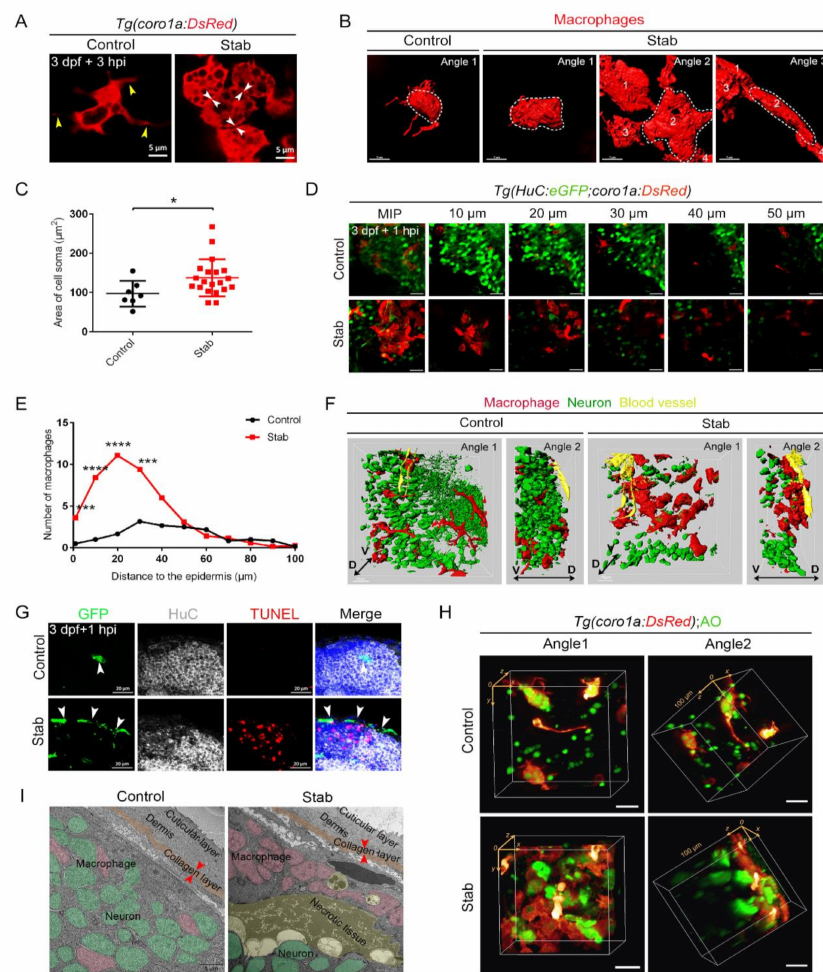
Figure 3. Aggregated macrophages formed a honeycomb network structure covering the wound surface. ( A ) Changes in macrophages morphology after injury. The yellow arrowheads indicate the branches. The white arrowheads indicate tight connections between cells. Scale bar, 5 µ m. ( B ) Three-dimensional reconstruction of the morphology of macrophages after injury. Angle 1 shows the morphology of individual cells and Angles 2 and 3 indicate tight connections between cells. Scale bar, 7 µ m. ( C ) Statistic analysis of the area of cell soma surface at 3 hpi. Control, 97.08 ± 12.37 µ m 2 n = 7; Stab, 137.50 ± 10.61 µ m 2 n = 20. ( D ) Distribution of macrophages and neurons on different layers of the Z axis at 1 hpi. The number on each panel represents the distances to the surface. Scale bar, 20 µ m. ( E ) Statistics analysis of coro1a + cells number at different layers with distinct distances from the epidermis at 1 hpi. ( F ) Three-dimensional images of the distribution of macrophages (red) and neuron (green) in Tg(coro1a:DsRed;HuC:eGFP) at 1 hpi. Yellow marks the blood vessels. D, dorsal; V, ventral. Scale bar, 15 µ m. ( G ) The immunofluorescent images of GFP, HuC and TUNEL on the frozen sections of Tg(coro1a:eGFP) brains at 1 hpi. The white arrowheads present the distribution of GFP + cells. Scale bar, 20 µ m. ( H ) The location of macrophages and AO + signals in 3D view. Scale bar, 20 µ m. ( I ) Transmission electron microscope image. Macrophages are in pink, neurons are in green, apoptotic or necrotic tissue is in yellow and the collagen layer beneath the skin is in orange. The red arrowheads indicate the width of the collagen layer. Scale bar, 5 µ m. (Data are shown as mean ± SEM. *, p < 0.05; ***, p < 0.001; ****, p <